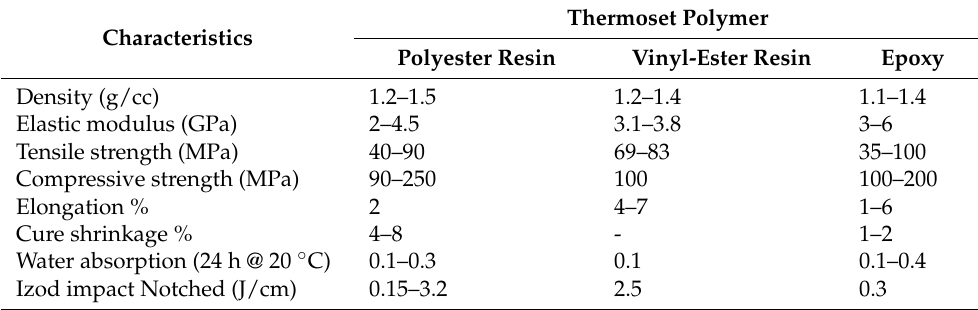
Table 2. General characteristics of thermoset polymer